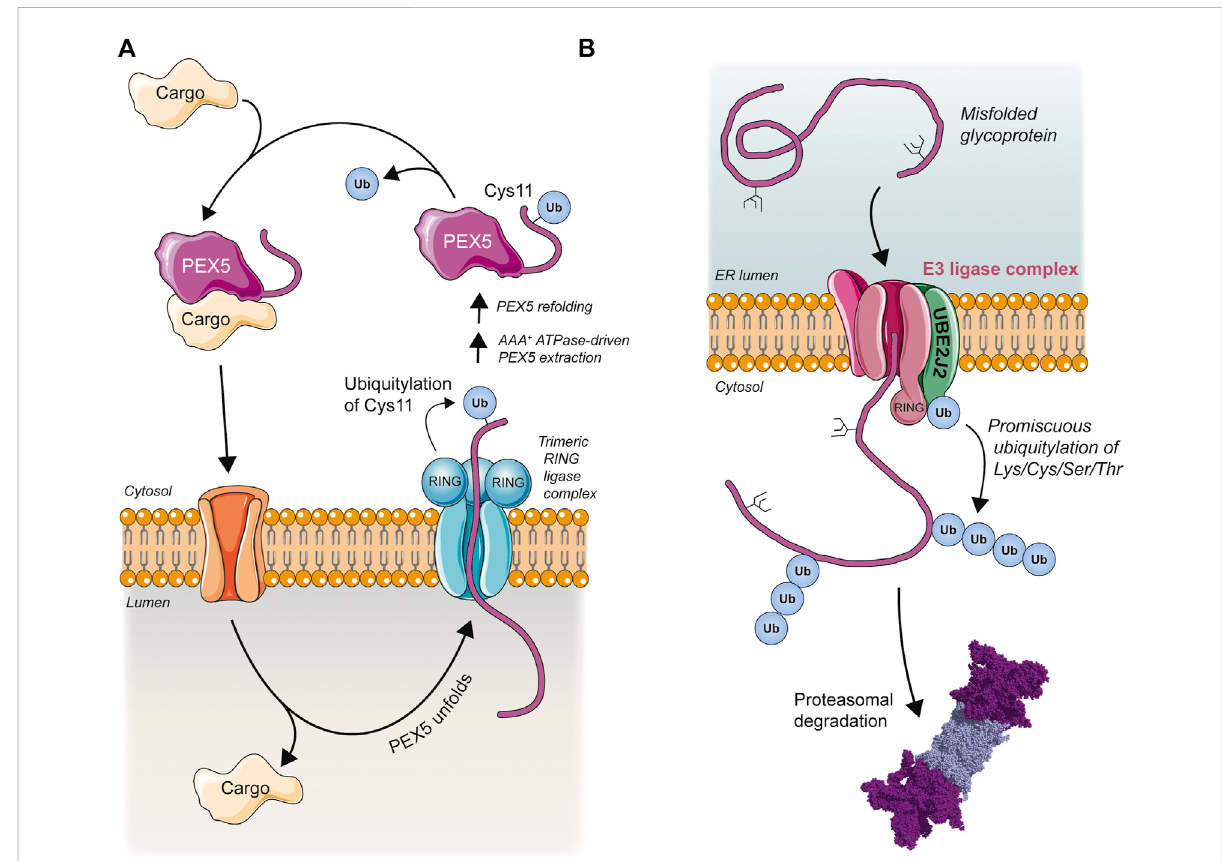
FIGURE 6 Membrane-spanning E3 ligase complexesfacilitate non-lysineubiquitylation during PEX5recycling andER-associated proteindegradation. (A) Cargo proteins destined for peroxisomal import are recognized in the cytosol by PEX5. PEX5 and cargo then translocate from the cytosol into the lumen of theperoxisome. The unstructuredN-terminus of PEX5 inserts into the pore of an E3 ligasecomplex containing three RING-type E3s and is monoubiquitylated on a cysteine residue, triggering the extraction of PEX5 from the peroxisome by a hexameric ATPase. This extraction is accompaniedbyPEX5unfoldingandcargorelease.OnceinthecytosolPEX5refoldsandisdeubiquitylated,allowinganewroundofcargoimportto begin. (B) Misfolded or unfolded glycoproteins in the ER lumen are retrotranslocated into the cytosol by an E3 ligase complex and ubiquitylated by this complex upon emergence on the cytosolic side. The membrane-bound ubiquitin conjugating enzyme UBE2J2 acts with the ligase complex to modify a range of amino acid residues (Lys/Cys/Ser/Thr) in the misfolded target protein, triggering its proteasomal